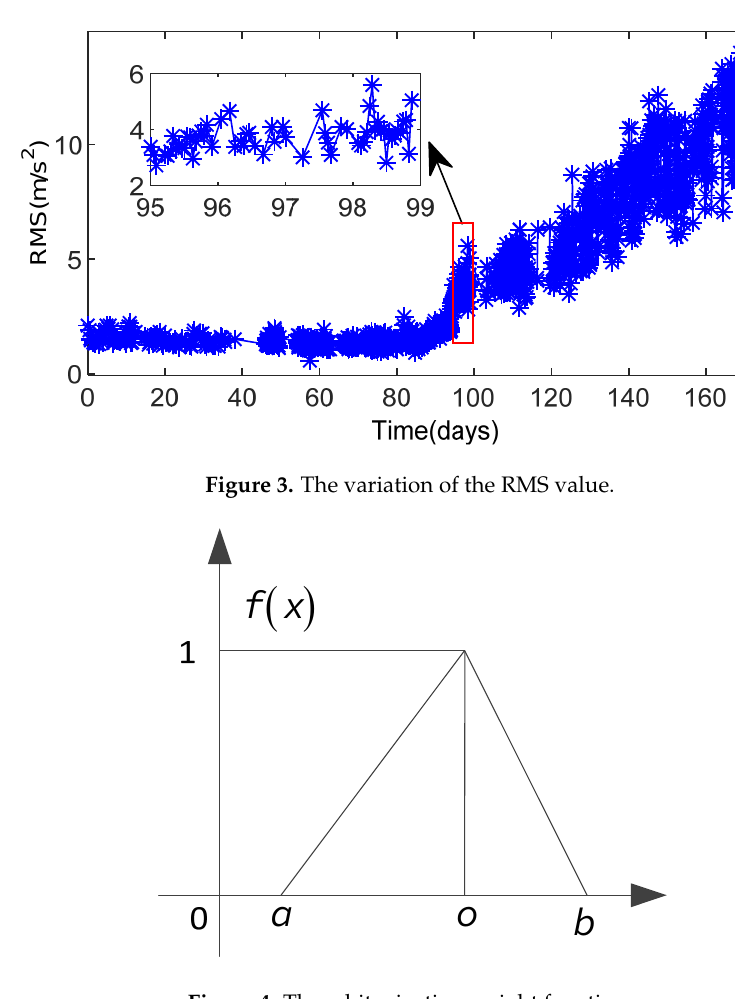
Figure 4. The whitenization weight function.